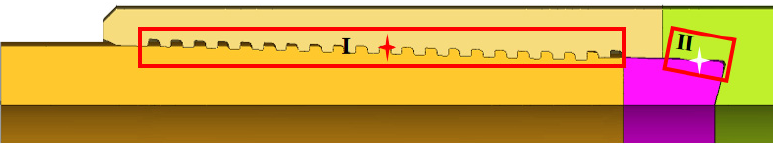
Figure 4. The section diagram of connection.